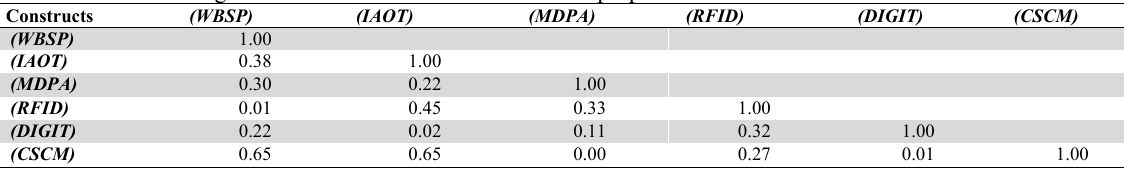
Inter-correlations among five ICT constructs and CSCM within proposed